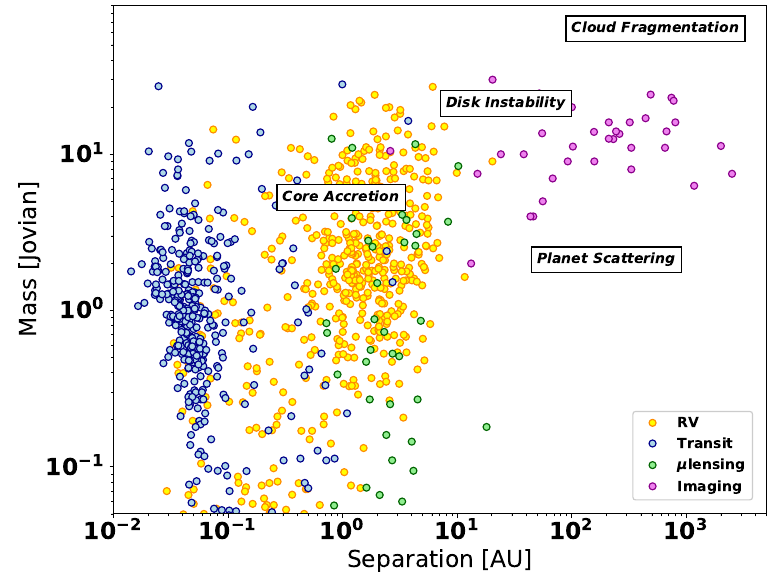
Figure 1. Orbital distances and mass distributions of exoplanets from radial velocity, transit, microlensing, and direct imaging methods. Data gathered from NASA Exoplanet